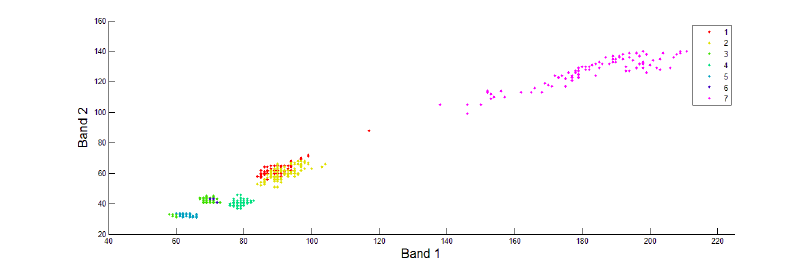
Figure 4: The scatter plot of the test samples for the graph-fuzzy clustering replaced by FCM for the IRS